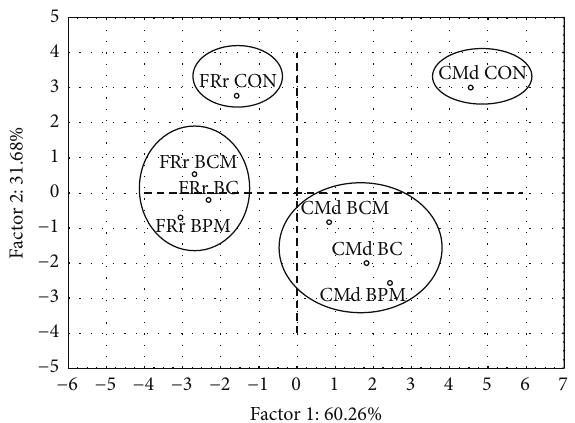
Figure 1: Principal Component Analysis of the evaluated cases